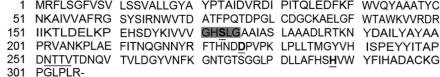
The deduced ATL amino acid sequence. The conserved sequence G-X-S-X-G in common lipases is indicated by the shadowed box, the catalytic triad Ser173-Asp 226-His 288 is in boldfont and underlined, and the putative glycosylation site 252–255, NTTV, is underlined.